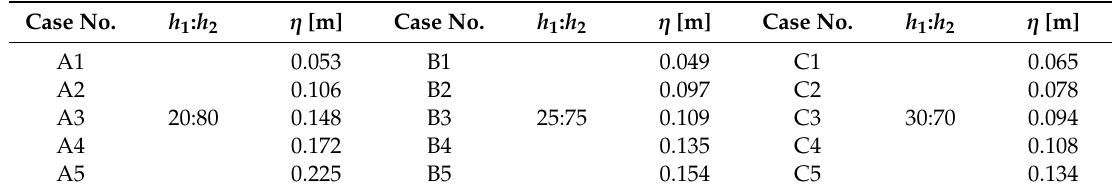
Table 1. Amplitude and fluid depth ratio in each numerical simulation.